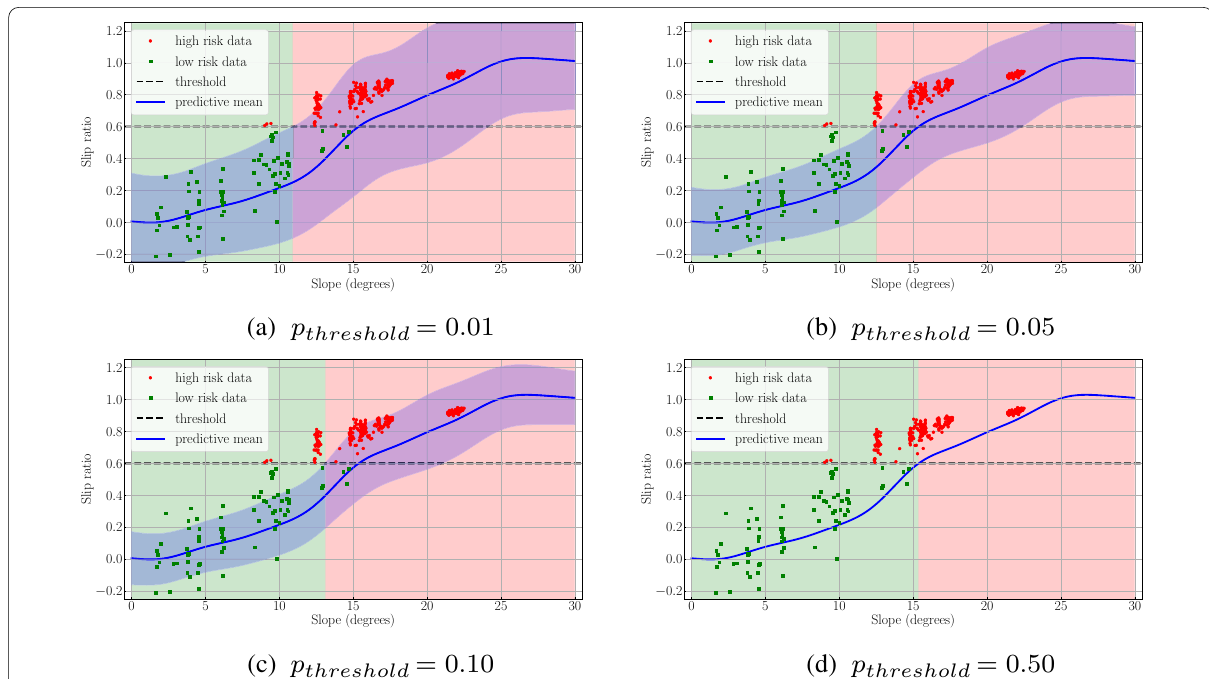
Fig. 13 Classification results of risk levels in Evaluation 4. The red and green areas represent the classified “ high-risk” and “ low-risk” slopes, respectively. The blue curve represents the predictive slip mean, while the blue-shaded area represents the confidence interval corresponding to the risk probability threshold p threshold . The dashed line represents the slip threshold value y threshold = 0.6 with which the risk level was classified. The red and green points represent the data of high and low risk, respectively. The slip regression model was trained from the target data on slopes shallower than 5 ◦ . Lower p threshold makes the risk level boundary shift to a shallower slope and provides more conservative risk prediction. Results for the rough sand surface class are